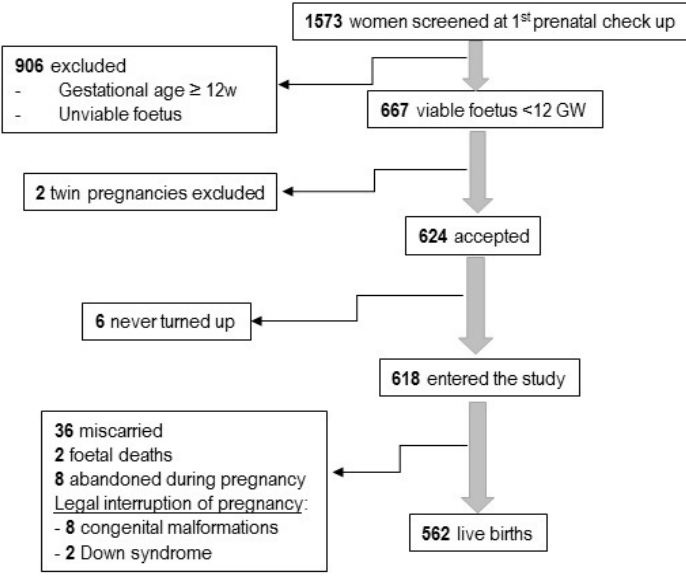
Figure 1. Flow chart of participation in the study. Table 1. Participant characteristics ( n = 612).